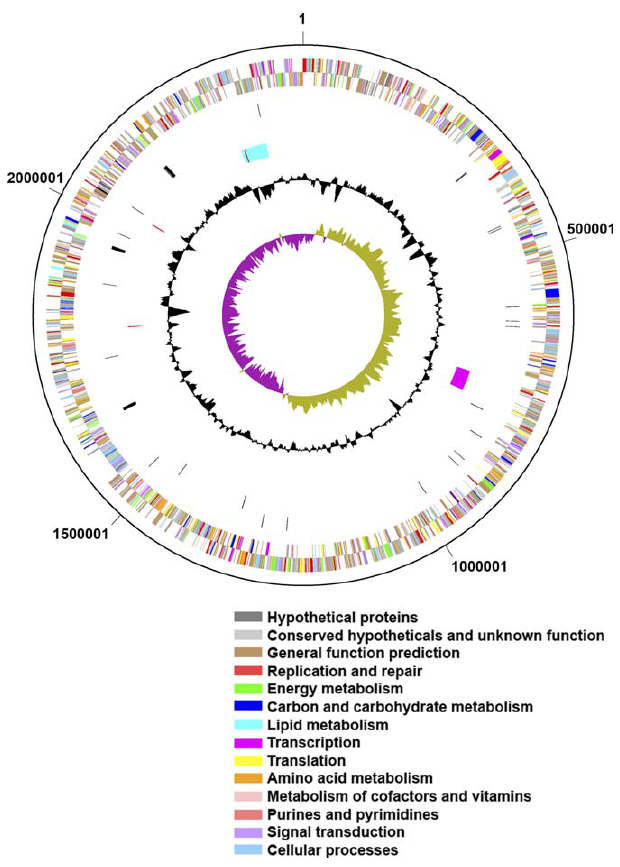
Figure 1. Circular Map of the Thiom. crunogena XCL-2 Genome The outer two rings (rings 1 and 2) are protein-encoding genes, which are color-coded according to COG category. Rings 3 and 4 are tRNA and rRNA genes. Ring 5 indicates the location of a prophage (magenta), phosphonate/heavy metal resistance island (cyan), and four insertion sequences (red; two insertion sequences at 2028543 and 2035034 are superimposed on this figure). The black circle indicates the deviation from the average %GC, and the purple and green circle is the GC skew ( ¼ [G (cid:2) C]/[G þ C]). Both the %GC and GC skew were calculated using a sliding window of 10,000 bp with a window step of 100. DOI: 10.1371/journal.pbio.0040383.g001